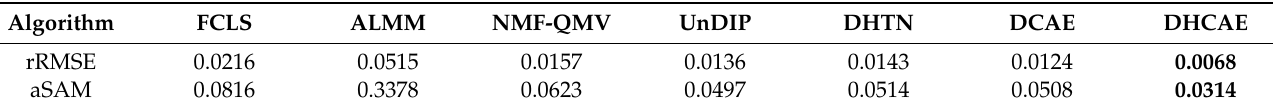
Table 2. Quantitative performance on the Jasper Ridge dataset without noisy bands by various approaches. The best result is shown in bold.